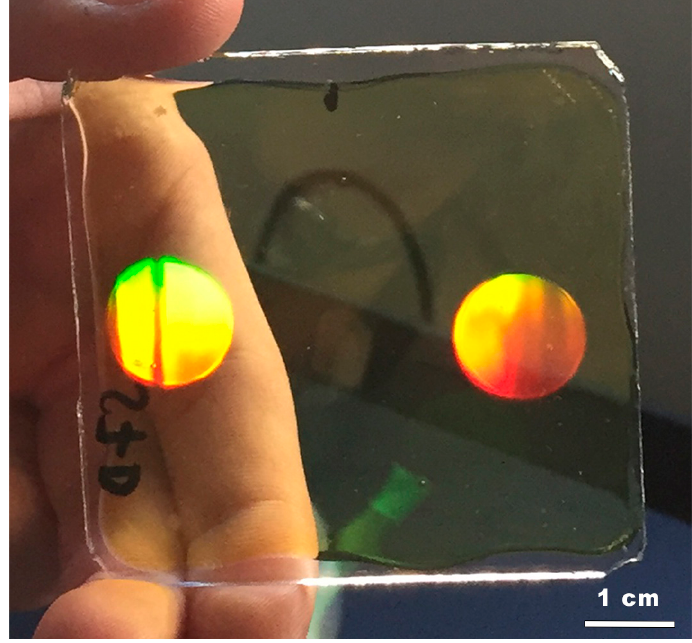
Figure 8. Photography of two HLs daylight-illuminated.